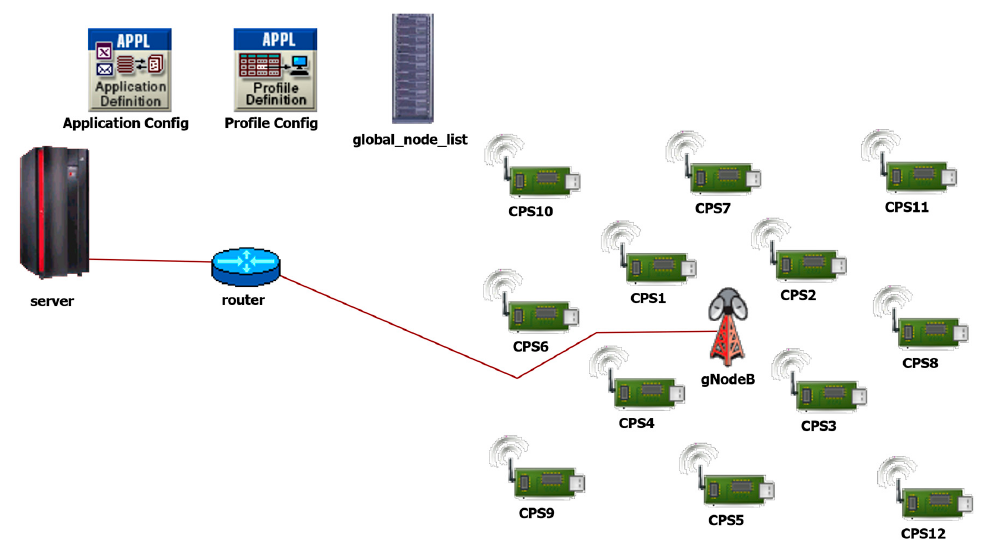
Figure 1. Project model [29].